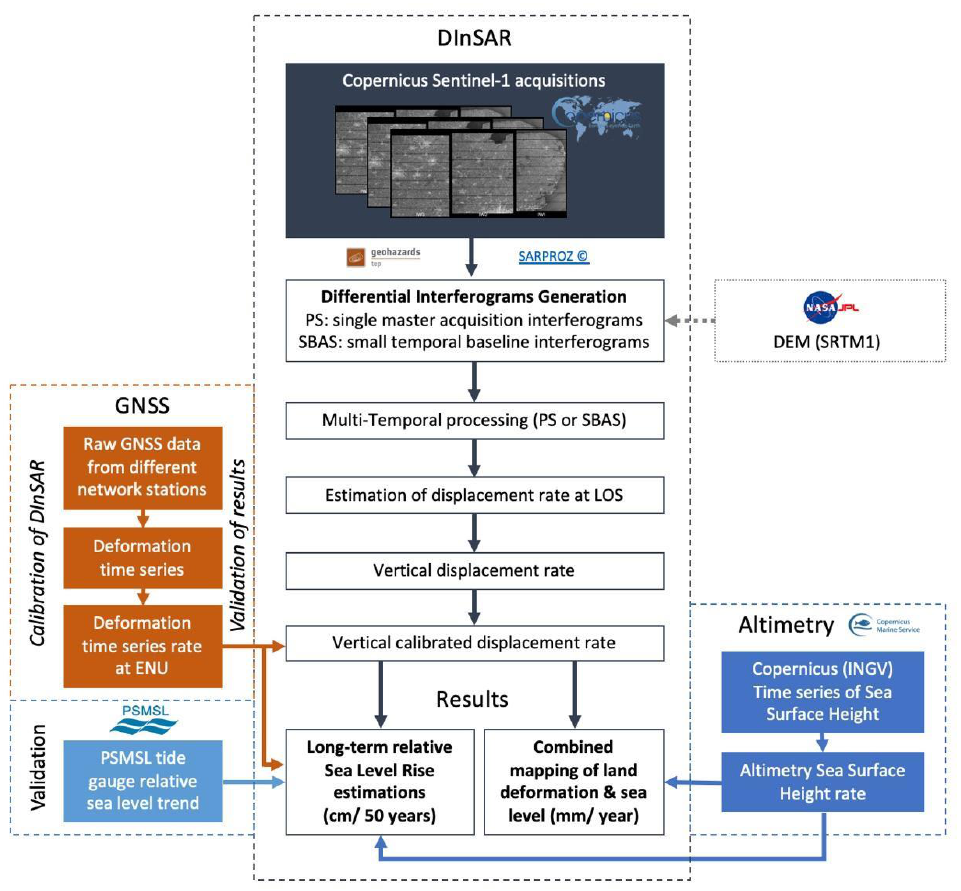
Figure 2 . Workflow of the methodological approach. The boxes in the middle represent the intermediate and final products while the peripheral boxes indicate the data used. GNSS stands for global navigation satellite system; DInSAR for differential synthetic aperture radar interferometry; satellite system; DInSAR for di ff erential synthetic aperture radar interferometry; ENU for east-north-up; ENU for east-north-up; PSMSL for permanent service for mean sea level; PS for permanent scatterers; PSMSL for permanent service for mean sea level; PS for permanent scatterers; SBAS for small baselines SBAS for small baselines subsets; LOS for line of sight; DEM for digital elevation model; INGV for subsets; LOS for line of sight; DEM for digital elevation model; INGV for Istituto Nazionale di Geofisica Istituto Nazionale di Geofisica e Vulcanologia e